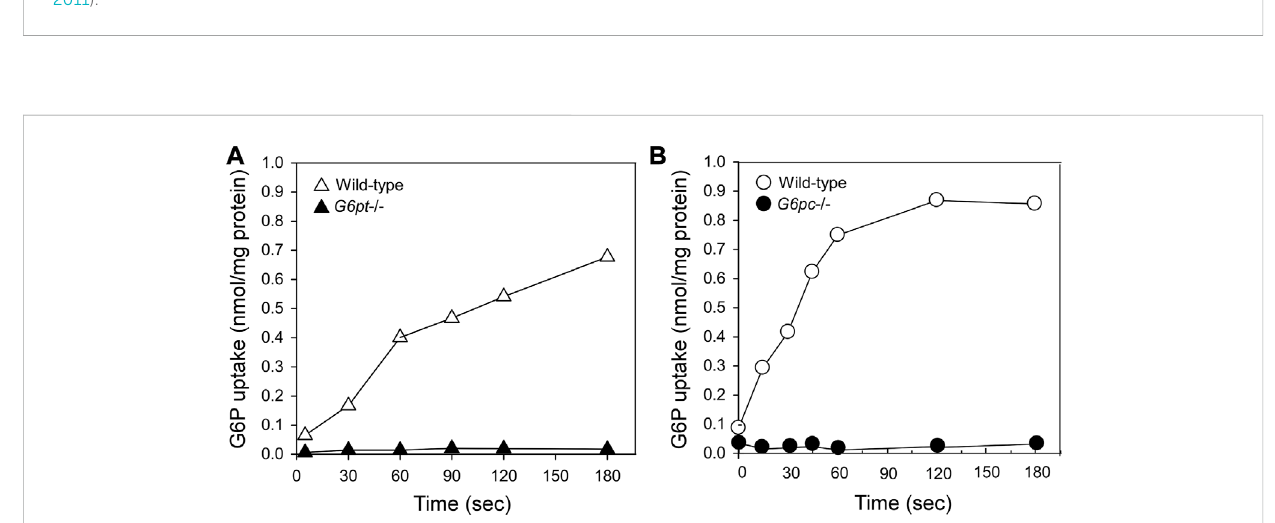
FIGURE 3 G6Pase- α and G6PT are functionally co-dependent. Microsomal G6P uptake was measured using [U 14 C] G6P (Lei et al., 1996; Chen et al., 2003). Intact hepatic microsomes from WT mice transport G6P ef fi ciently (Lei et al., 1996; Chen et al., 2003). (A) Intact hepatic microsomes from the G6pt − /